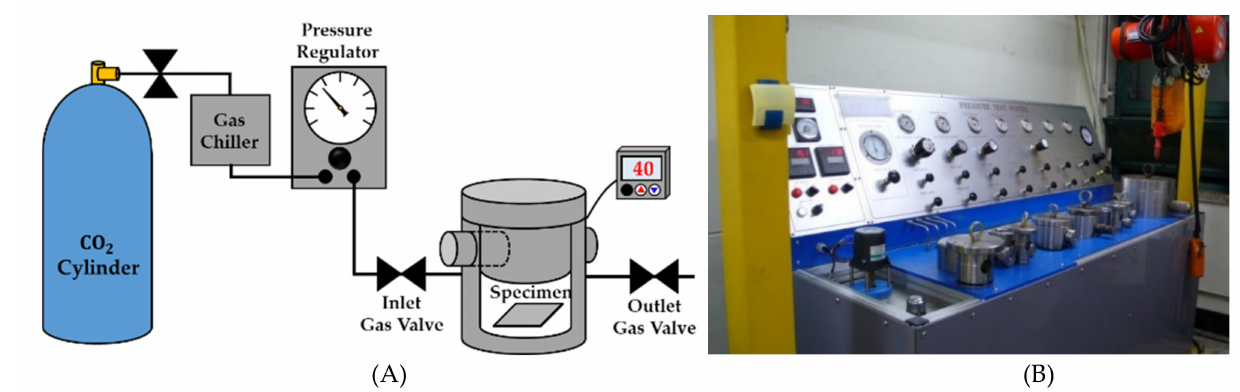
Figure 2. ( A ) Schematic of the solid-state batch foaming process; ( B ) experimental equipment of the solid-state batch foaming process used in this